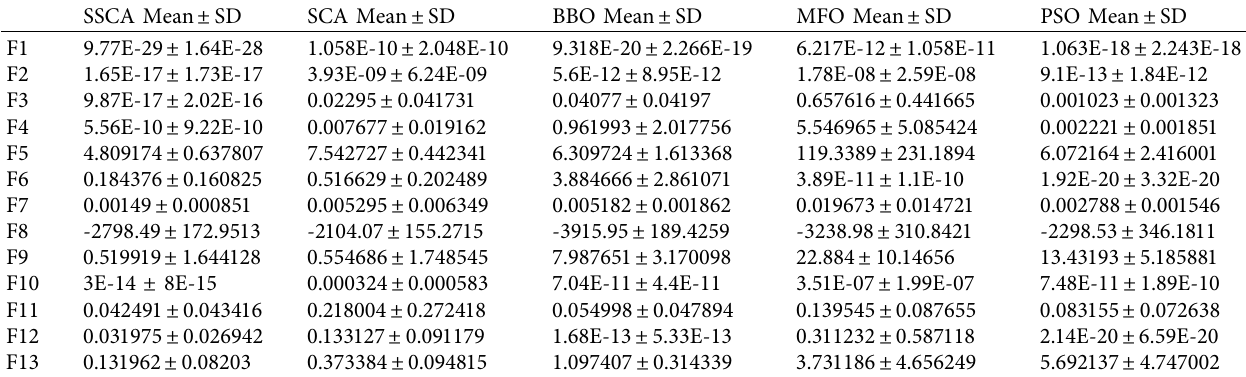
Table 1: Statistical analysis of diferent methods (best values are presented in bold).